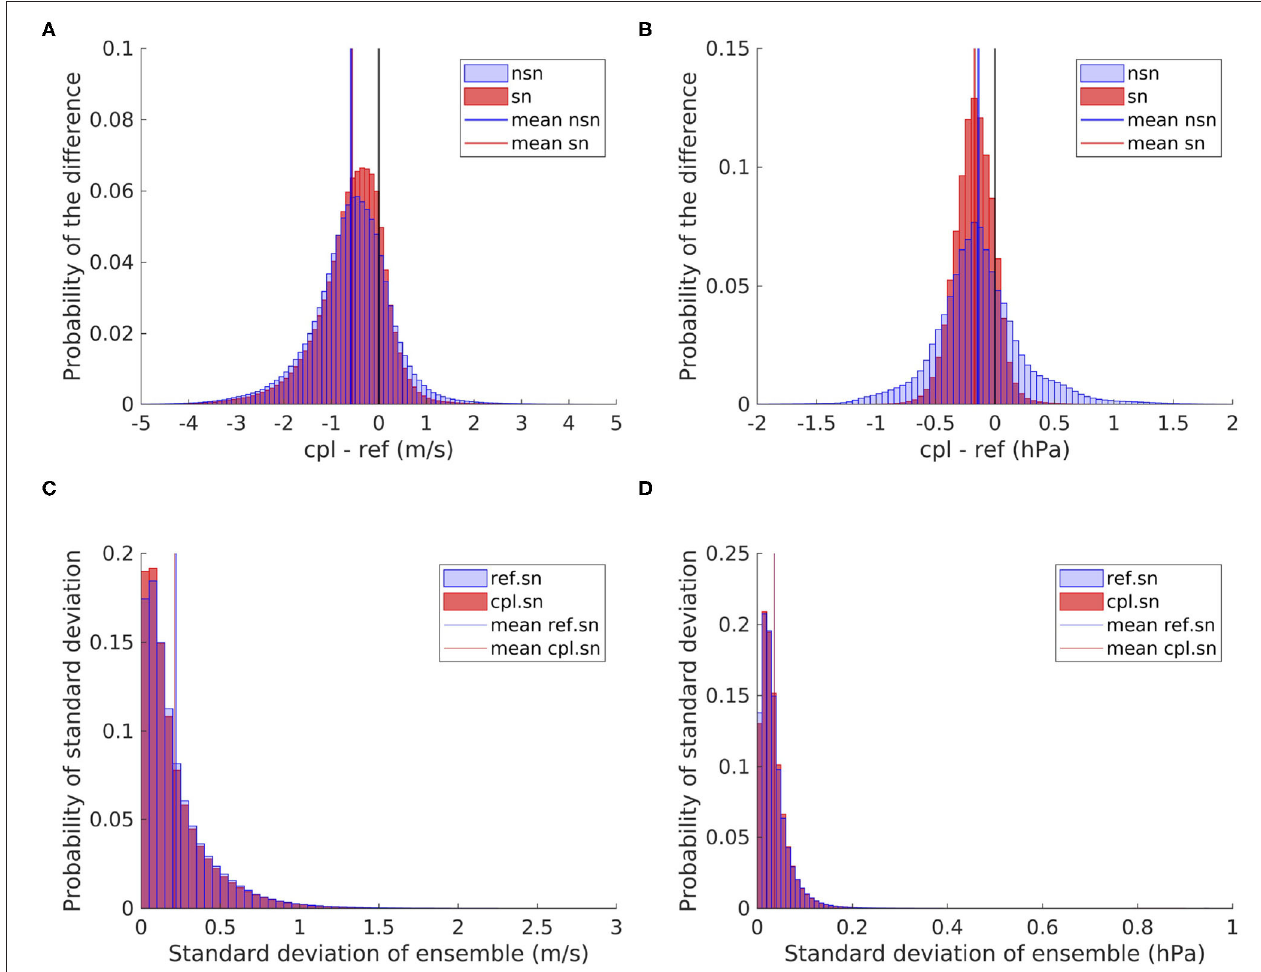
FIGURE 9 | Histogram of the differences between the coupled and reference ensembles in the wind speed (A) and MSLP (B) within the North Sea, as well as the standard deviation of the reference and coupled ensembles within the North Sea area for the wind speed (C) and MSLP (D)